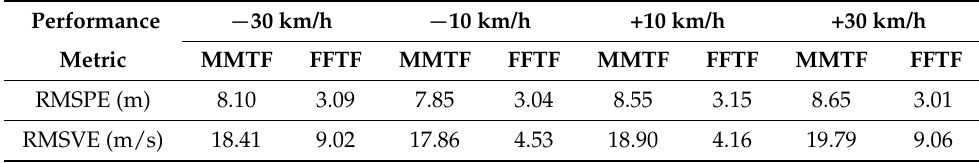
Table 3. Simulation results under various relative velocities in the long-range